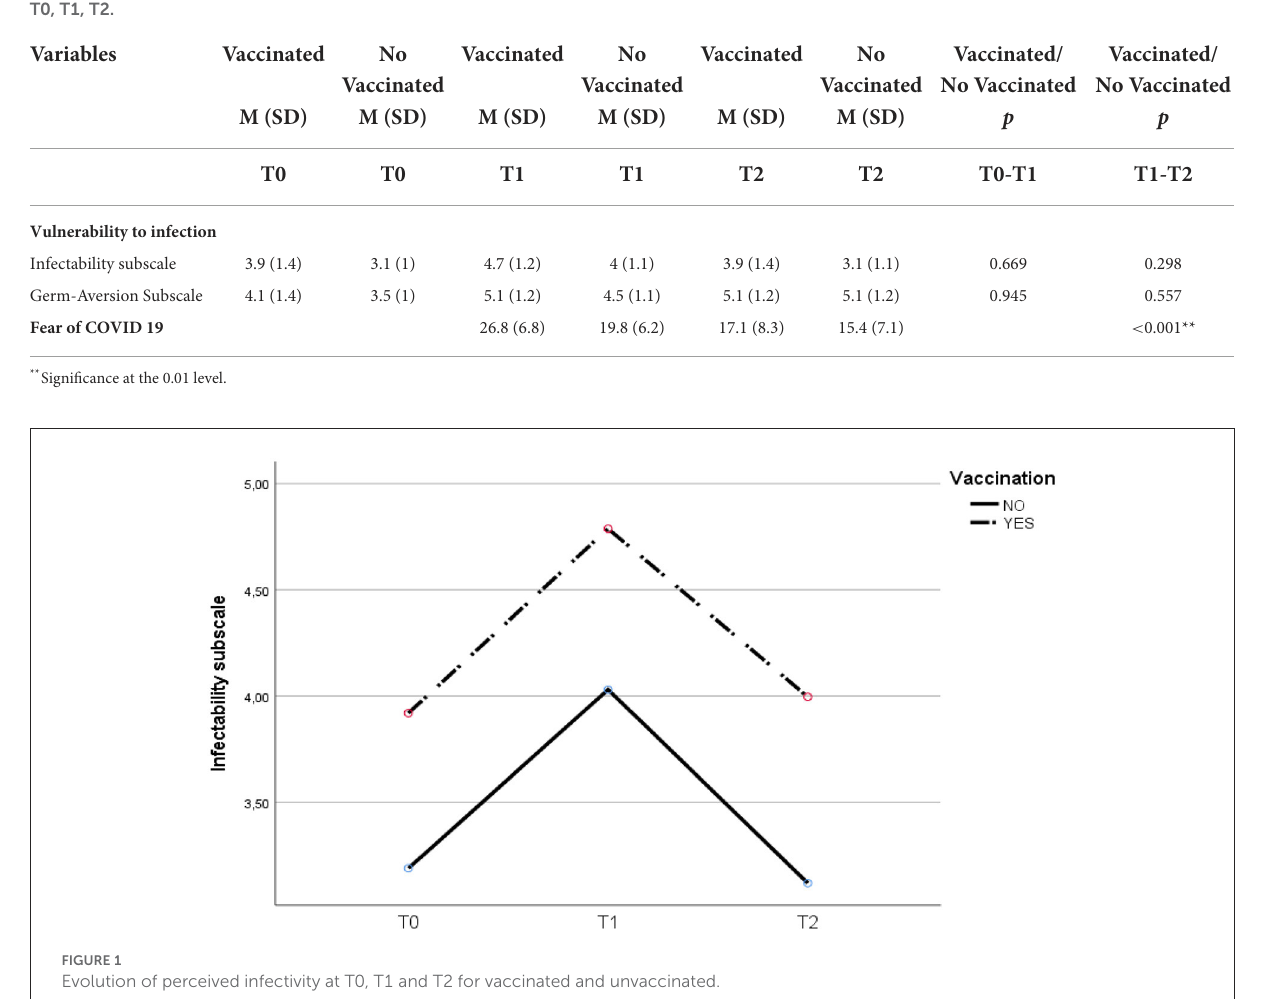
of vaccination and dental avoidance on the 1 fear of COVID-19 T1-T2 was significant [ F (1,3) = 4.92; p = 0.027; η 2 =